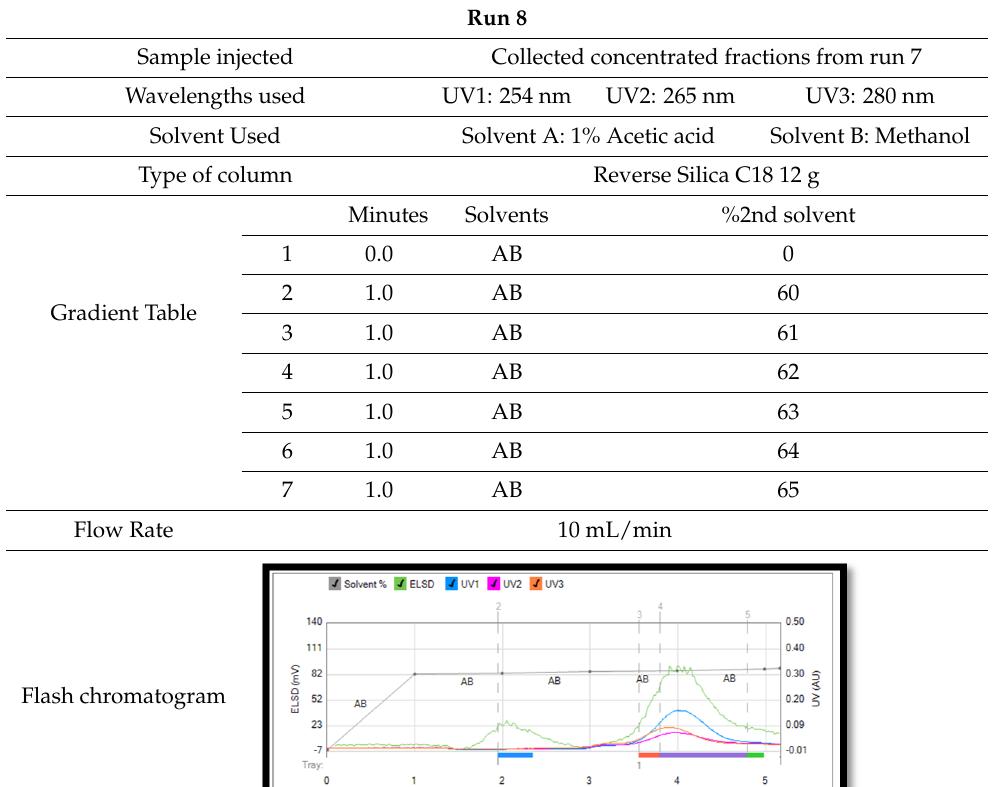
Table 2. Demonstrates the gradient solvent system, UV detection, type of column, and flash chro- matogram for run 8, and colors indicating the fractions